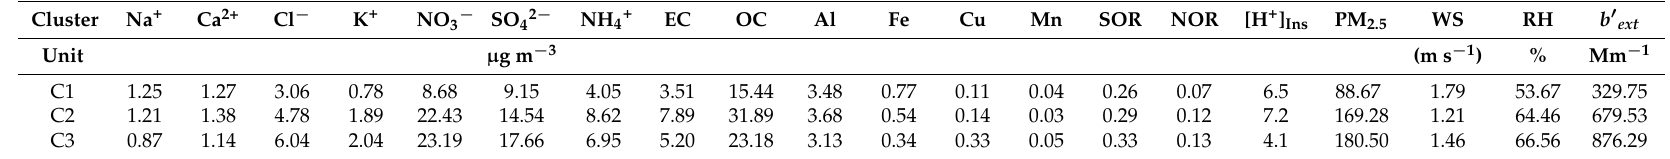
Table 6. The statistical results of PM 2.5 and PM 2.5 -associated species of each kind of